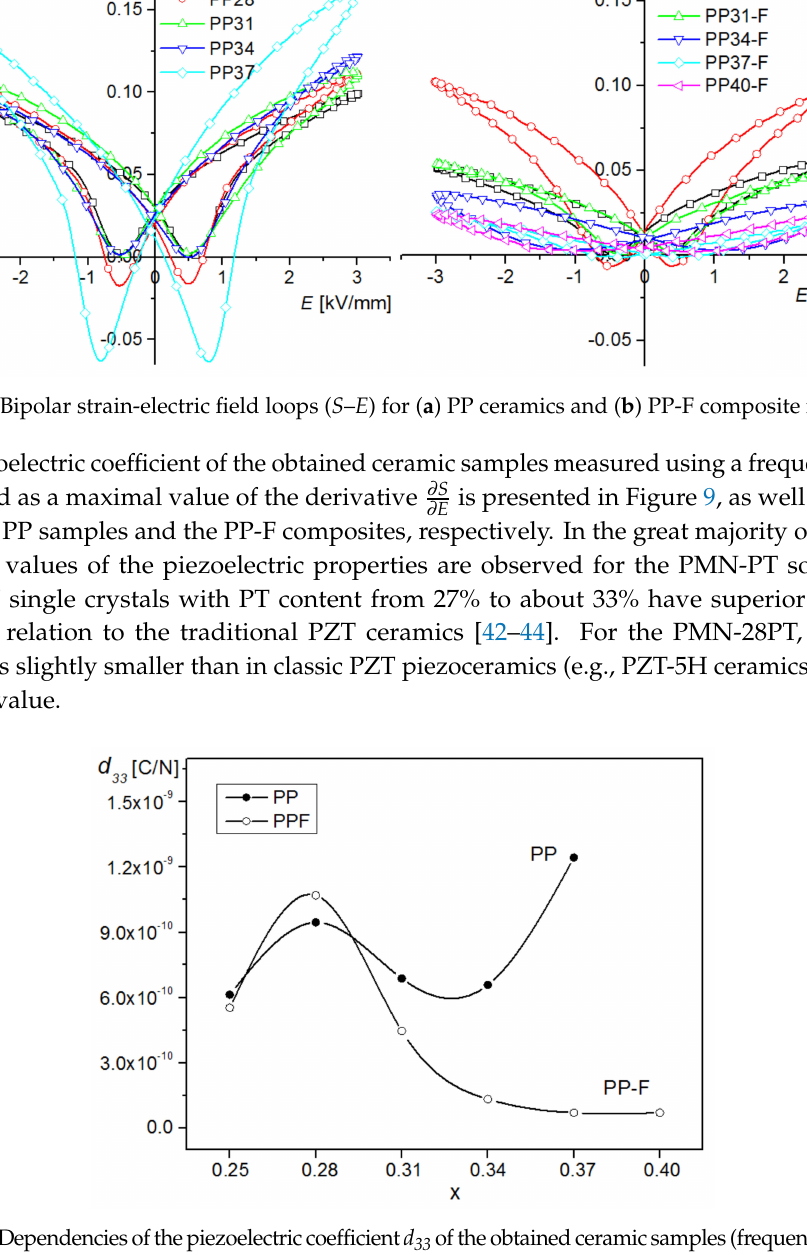
Figure 9. Dependenciesofthepiezoelectriccoefficient d 33